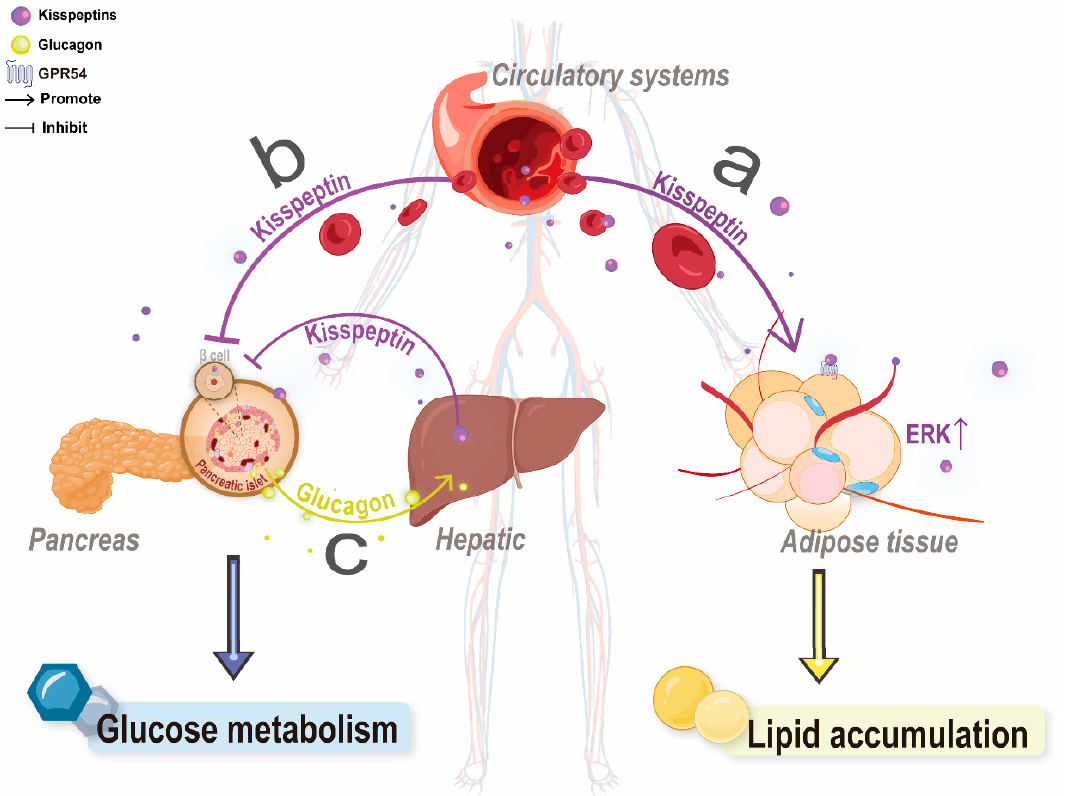
Figure 3. Peripheral kisspeptin regulation of glucose and lipid metabolism. ( a ) Circulating kisspeptin promotes lipid accumulation in adipose tissue. ( b ) Circulating kisspeptin stimulates pancreatic β -cells to reduce insulin secretion. ( c ) Hepatic secretion of kisspeptin stimulates pancreatic beta cells and impairs insulin secretion, while glucagon promotes hepatic secretion of kisspeptin and deteriorates glucose homeostasis (hepatic–pancreatic circuit).